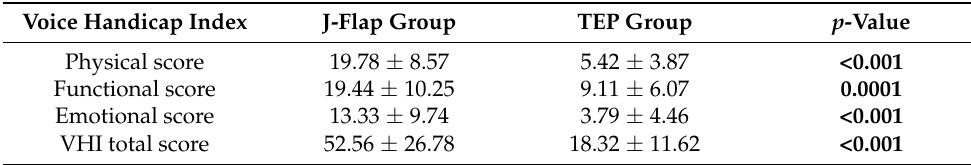
Table 4. Voice handicap index.